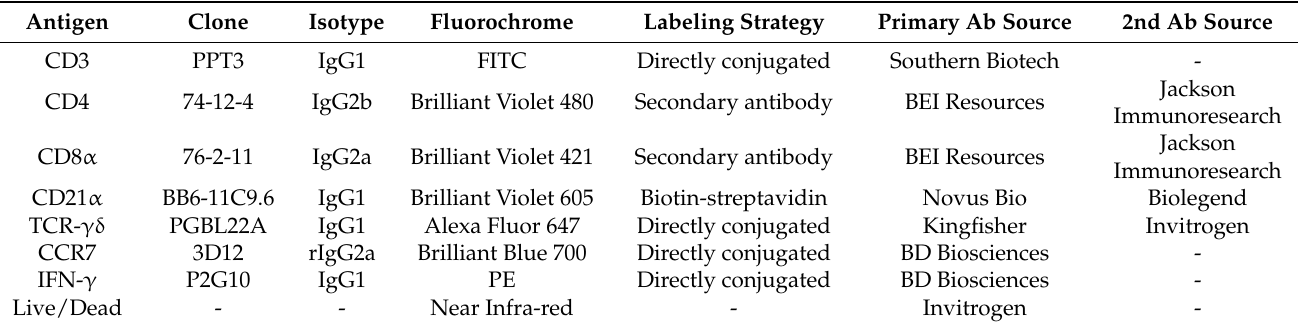
Table 1. Flow cytometry antibody staining